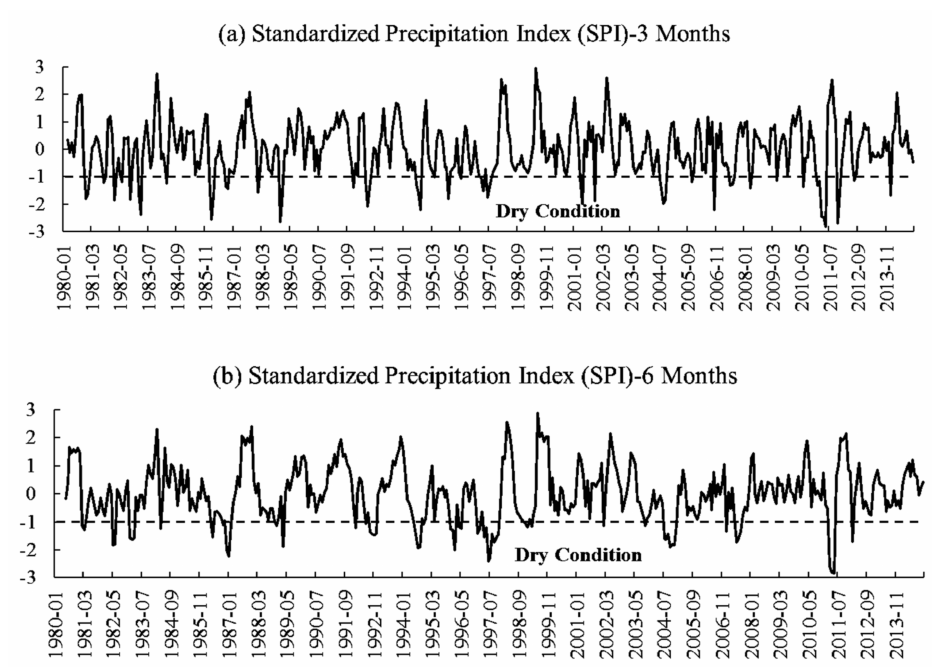
Figure 7. Standardized Precipitation Index of Yixing City for three and six month timescales from 1980 to 2014. ( a ) Standardized Precipitation Index (SPI)-3 Months; ( b ) Standardized Precipitation Index (SPI)-6